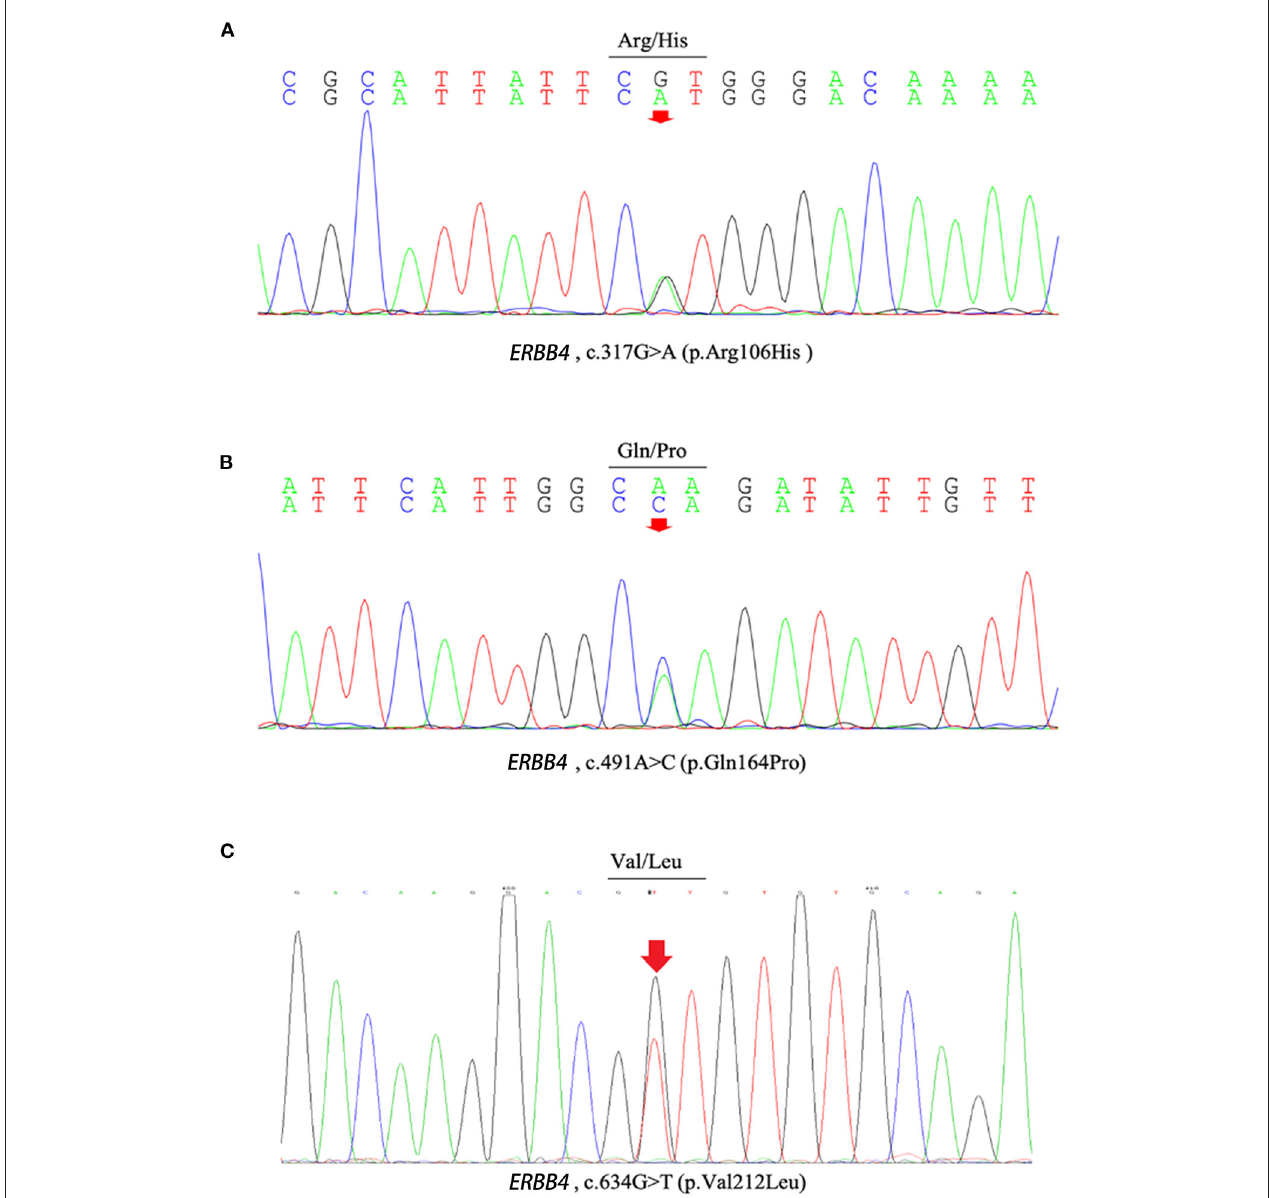
FIGURE 1 | The chromatograph of ERBB4 variants (p.Arg106His, p.Gln164Pro and p.Val212Leu). (A) The chromatograph of ERBB4 p.Arg106His variant. (B) The chromatograph of ERBB4 p.Gln164Pro variant. (C) The chromatograph of ERBB4 p.Val212Leu variant.